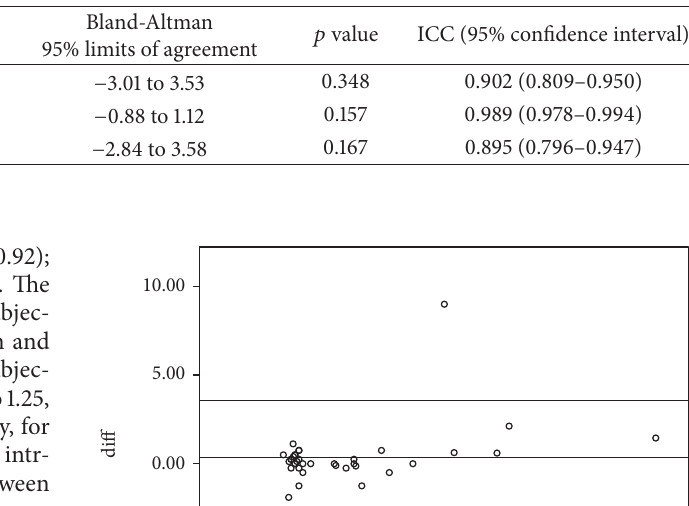
Table 2: The Bland-Altman 95% limits agreement and intraclass correlation coefficient for spherical equivalent.